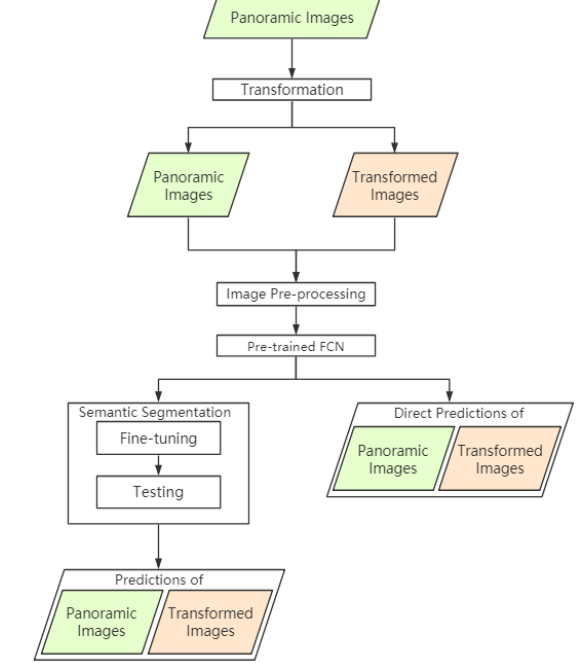
Figure 1. Workflow of the proposed street furniture